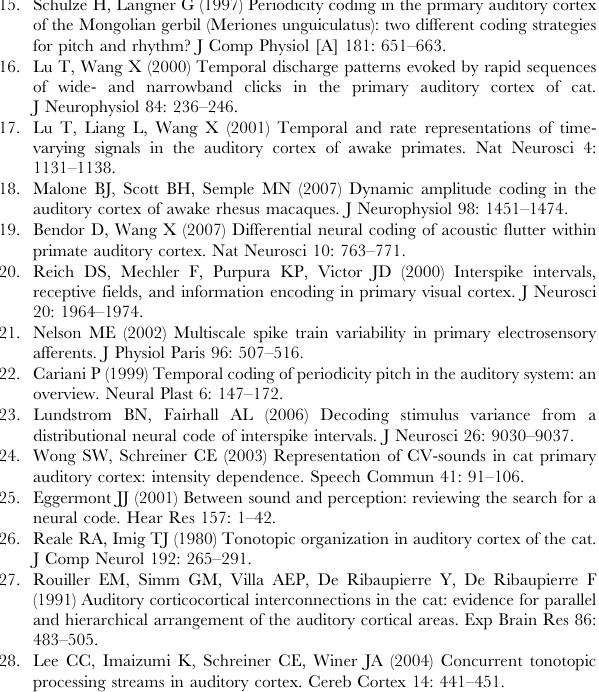
Figure S1 Two examples of RRTFs for VS and FR. (A, B) Poststimulus time histograms for two different sites. Response strength was normalized to the maximum responses at 1 Hz. (C, D) RRTF tuning curves for the same two sites. VS and FR are illustrated by magenta and cyan lines, respectively, and data points are fit by a polynomial cubic spline for illustration. Filled circles are significant VS values by a Rayleigh test (p , 0.001). Site identification and CF are shown in (C, D). Gray areas are the repetition rate range for the focus of our study. (A, C) Moderate VS site. FR showed band- pass property with high best repetition rate. VS information: 0.19 bits/stimulus. FR information: 0.33 bits/stimulus. ISI (1 ms) information: 0.34 bits/stimulus. ISI (10 ms) information: 0.74 bits/